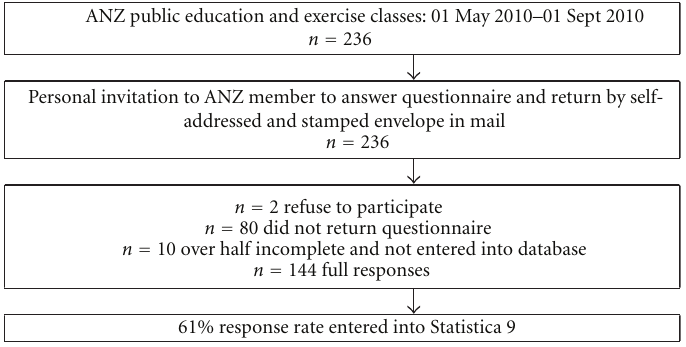
Figure 1: Flow chart: Method of data